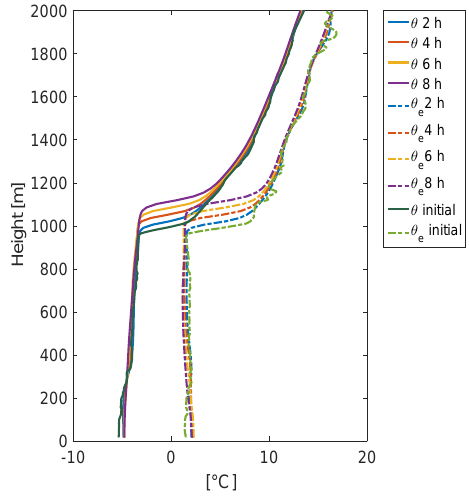
Figure 4. θ (left) and θ e (right) profiles of the initial conditions (dark green and green), and domain-averaged profiles after 2h (blue), 4h (orange), 6h (yellow), and 8h (purple) from the start of the control